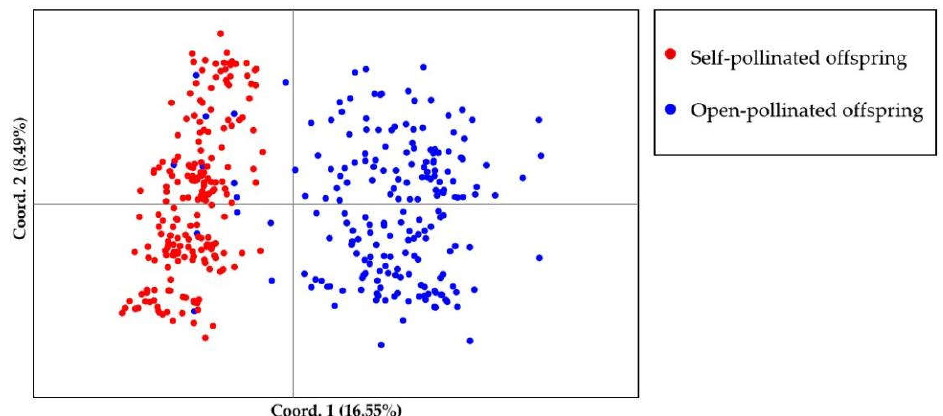
Figure 5. Scatterplot of the principal coordinate analysis (PCoA) for self- and open-pollinated offspring. Different colors represent individuals of self- and open-pollinated offspring.